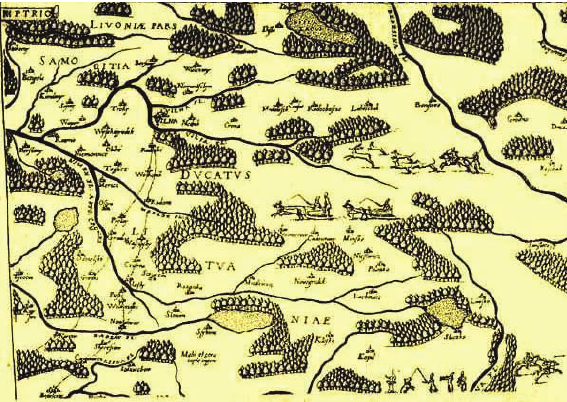
Fig. 9. Fragment of the map of Midle Europa by A. Pograbka (from B. Kordt atlas